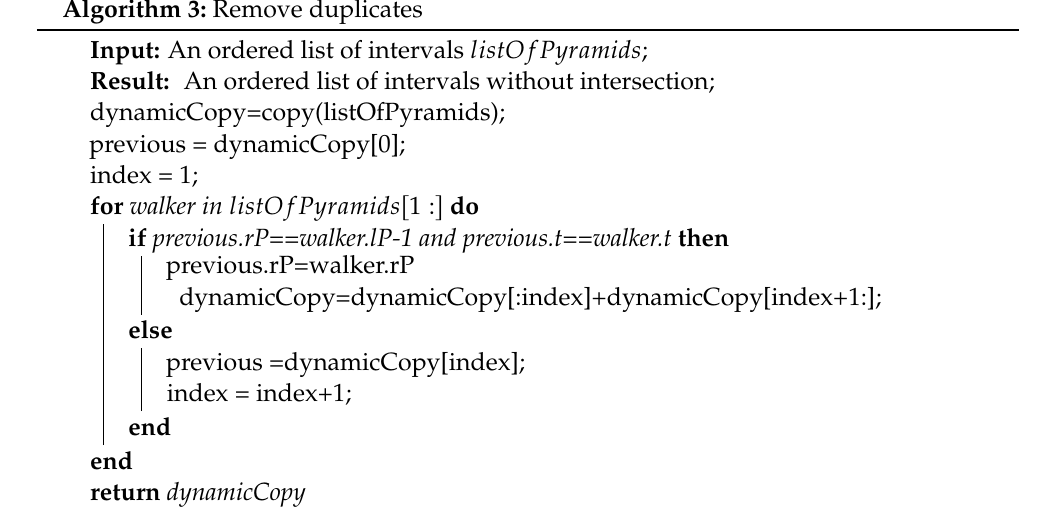
Algorithm 3: Remove